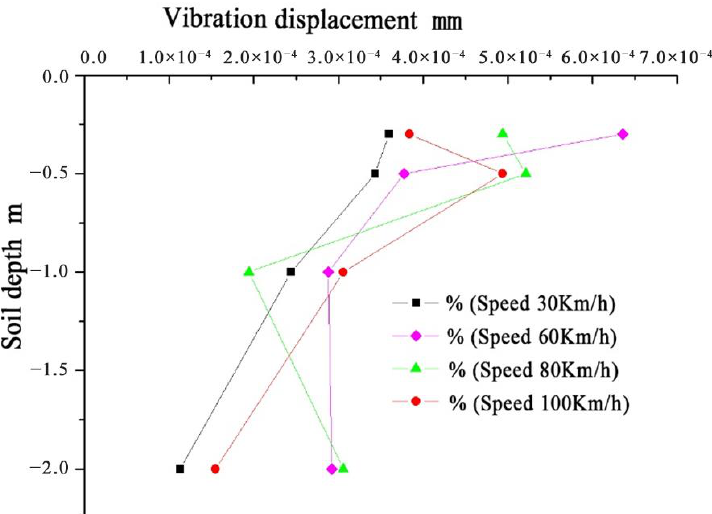
Figure 6. Foundation soil vibration displacement — depth distribution rule.